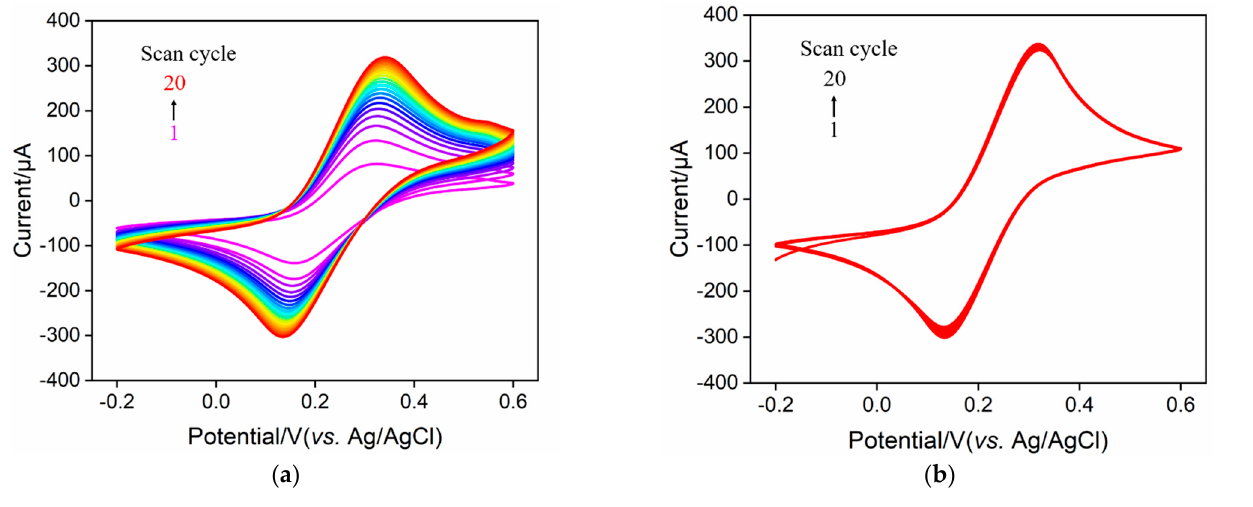
Figure 2. CV curves obtained on CS/ITO ( a ) or CS-rGO/ITO ( b ) electrode for 20 consecutive scans. The electrolyte solution is Fe(CN) 63 − /4 − (2.5 mM) containing 0.1 M KCl. The electrolyte solution is Fe(CN) 63 − /4 − (2.5 mM) containing 0.1 M